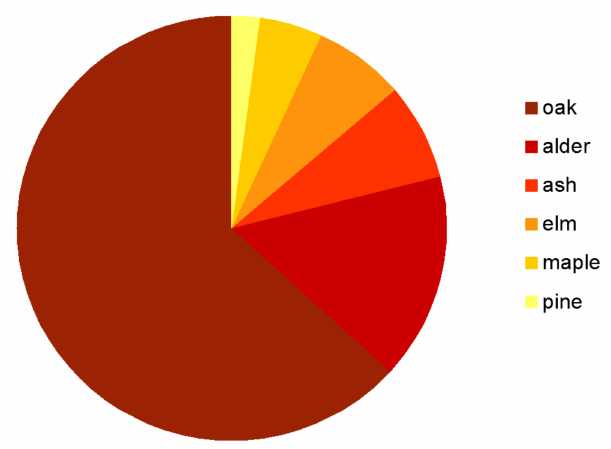
Figure 4. Percentage share of individual tree species within analysed